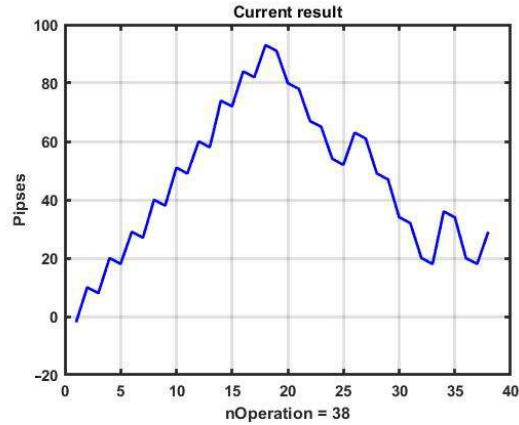
Figure 12. Performance of CSB in the example implementation.